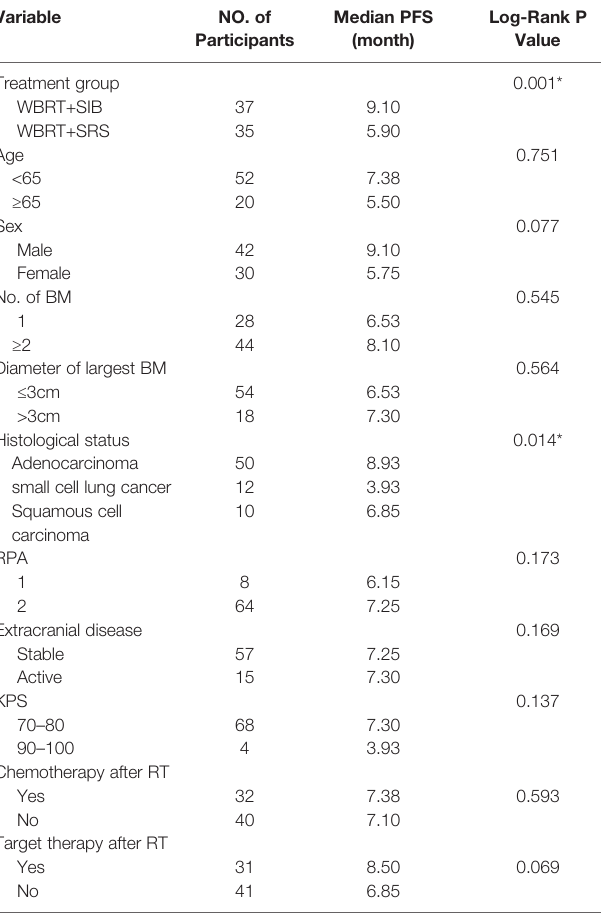
TABLE 4 | Survival-related factors on intracranial PFS in univariate